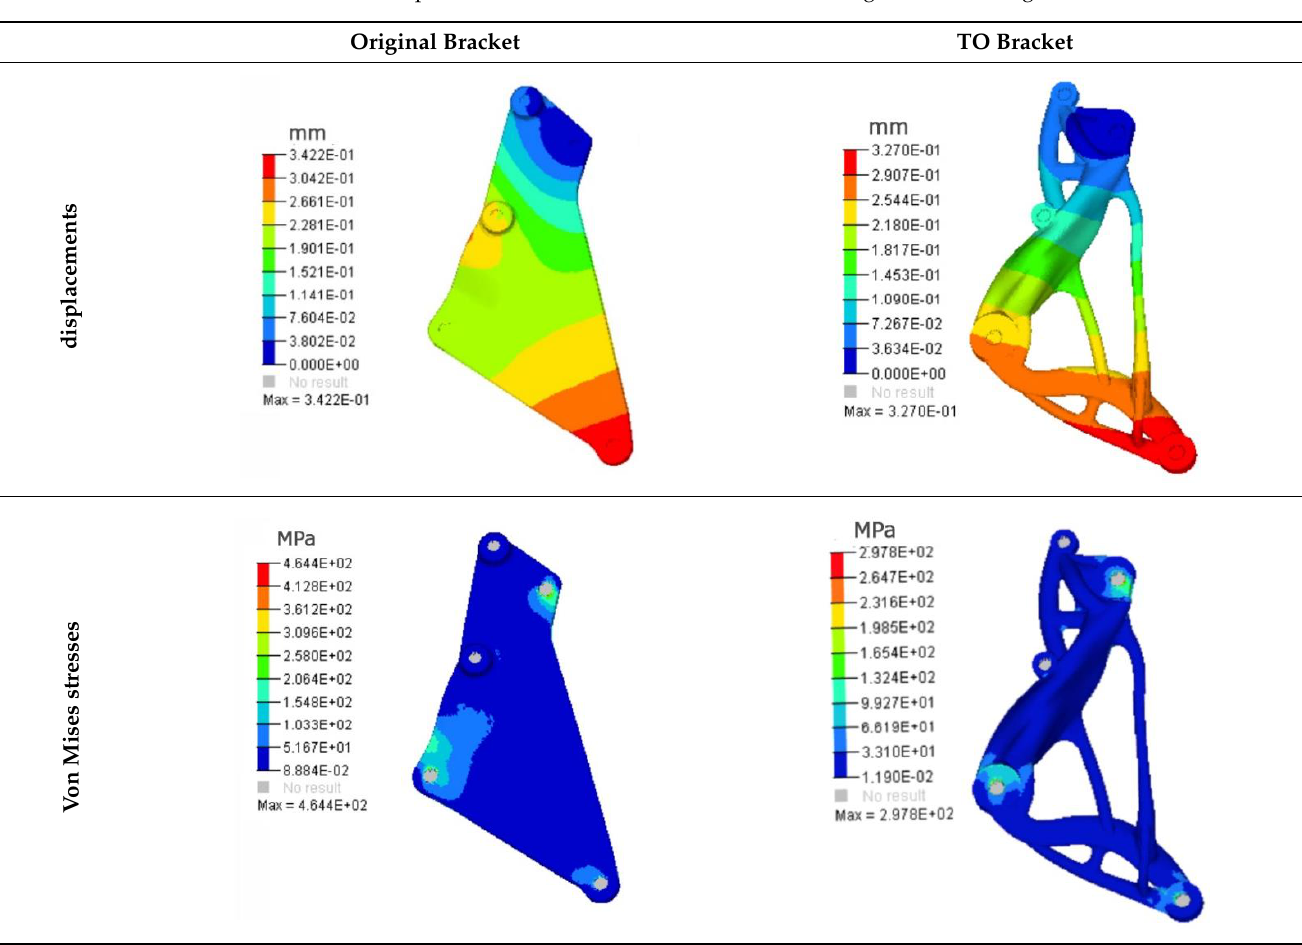
Table 1. FEA results for displacements and Von Mises stresses for the original and redesigned bracket.